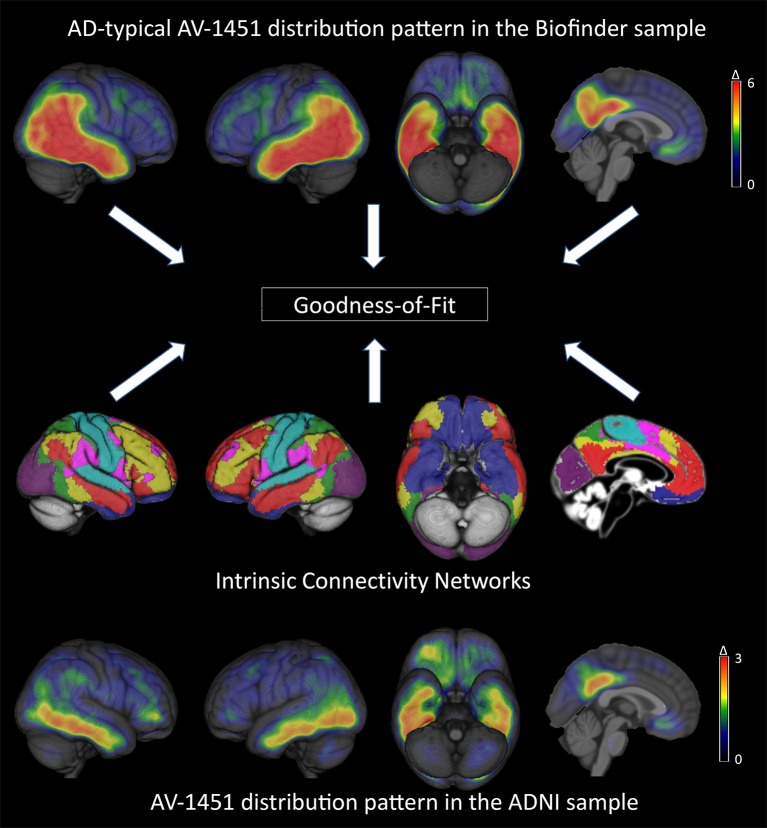
Brain-wide patterns of increased tau deposition in the BioFINDER and ADNI cohorts and illustration of the standardized intrinsic connectivity networks (for details see Supplementary Figure 1). The top and bottom row images represent mean Z-score images of the BioFINDER and ADNI patient samples. Note the different scales used for color-coded visualization of mean Z-score values in the BioFINDER and ADNI patient samples.